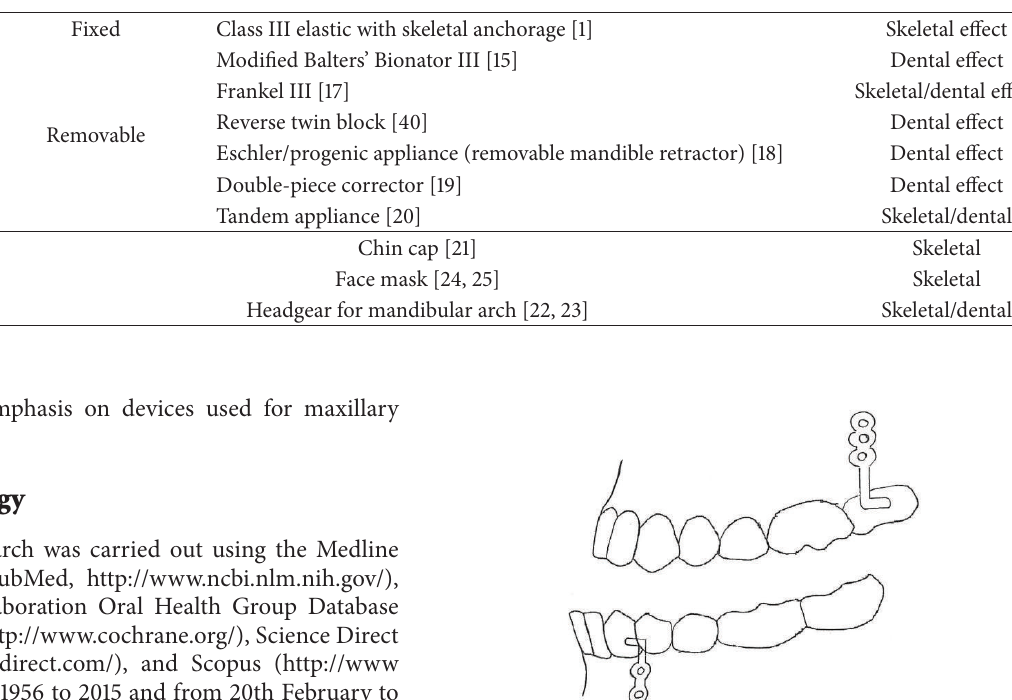
Table 1: Appliances for correction of class III malocclusion in growing patients.